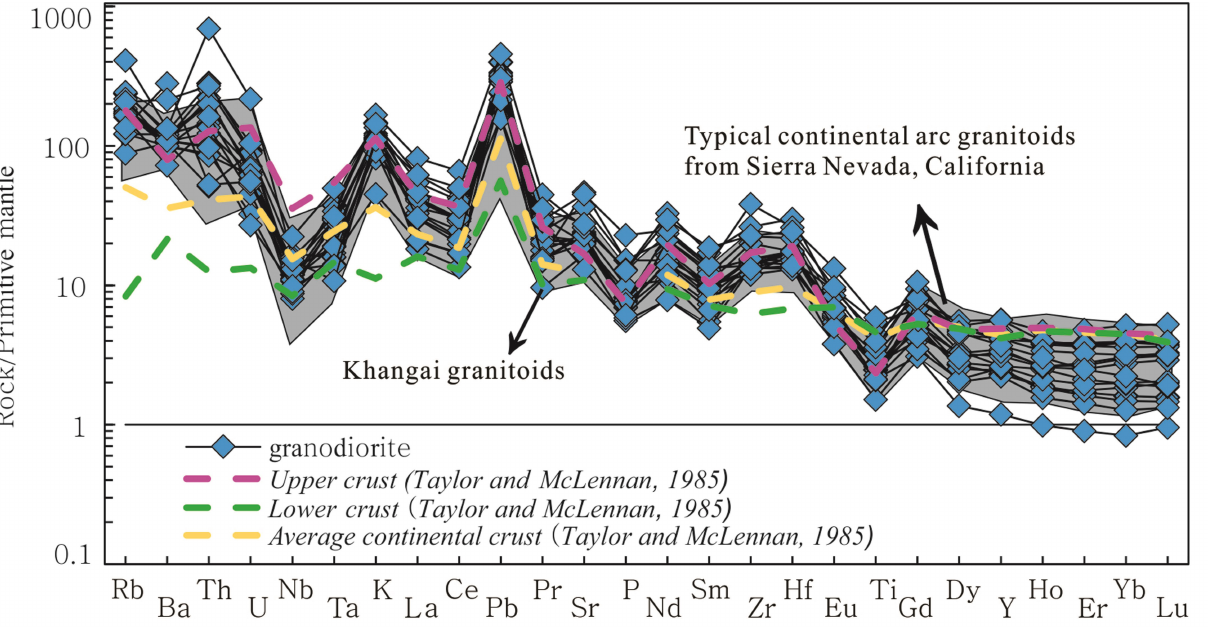
Fig. 12. Primitive-mantle-normalized multi-element patterns showing the composition of biotite–hornblende granodiorites of the Khangai area compared to subduction-related continental arc granitoids from the Sierra Nevada of California (shaded area; Cecil et al., 2012), showing the similarity of the compositions of the granitoids from these two areas. Data are normalized to the primitive mantle composition of Sun and McDonough